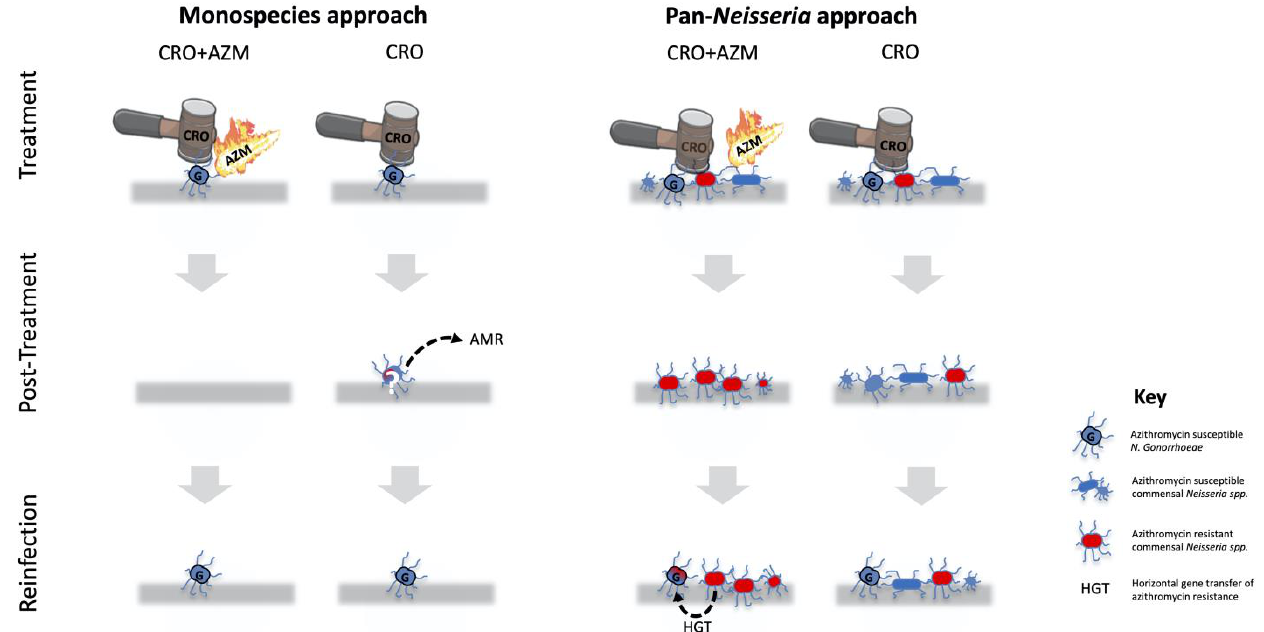
Figure 1. A schematic illustration of select differences between the monospecies and pan- Neisseria approaches to evaluating the risk of inducing resistance of proposed antimicrobial therapy for N. gonorrhoeae (NG/G). The monospecies approach only considers the effects of the treatment on NG. It thus favours dual therapy with ceftriaxone (CRO) and azithromycin (AZM), as this combination minimises the risk of treatment failure that could result in resistance. In the pan- Neisseria approach, monotherapy is favoured, as this is highly efficacious at eradicating NG and does this without selecting for widespread resistance (red bacteria) to macrolides in commensal Neisseria 14 days post-therapy (second panel). The pan- Neisseria , but not the monospecies approach, is cognisant of the risk of the genes conferring macrolide resistance in commensal Neisseria being passed on to a NG reinfection via horizontal gene transfer (HGT; third panel). The rationale for only representing CRO and CRO/AZM as treatment options is that these are the predominant treatments currently recommended by the United States CDC and European IUSTI